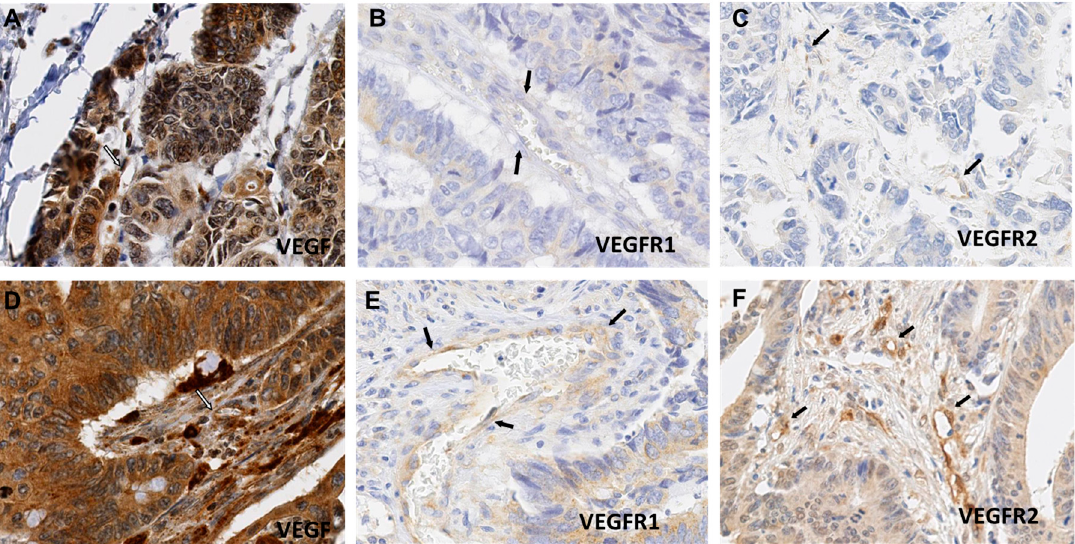
Figure 2. Heterogeneous VEGF, VEGFR-1 and VEGFR-2 expression in colorectal cancer (CRC) endothelial cells (ECs): VEGF expression in ECs was heterogeneous with an labelling index (LI) range from 10.9 to 90% ( A , D ); Anti-VEGFR-1 immunostaining shows rare positivity with an LI range from nearly 0 ( B ) to 20% ( E ) in endothelial cells. VEGFR-2 shows a much wider immunostaining, with an LI range from 10 ( C ) to 72% ( F ). (Magnification: 400 × ). The arrows are pointed at vessels.